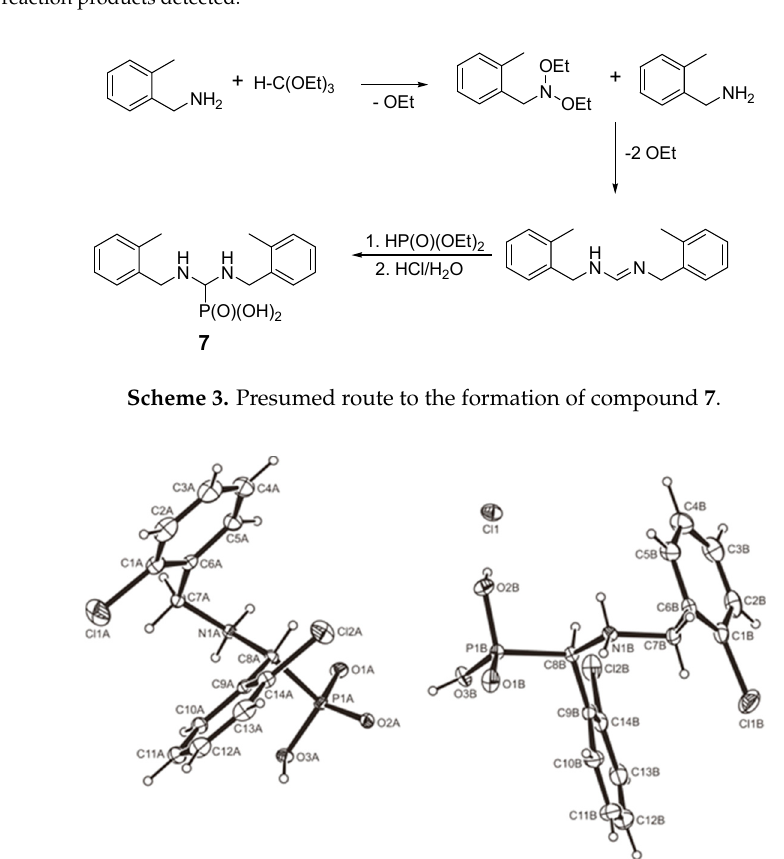
Figure 1. The crystal structure of molecule 6d . Displacement ellipsoids are drawn at a 20% probability level.